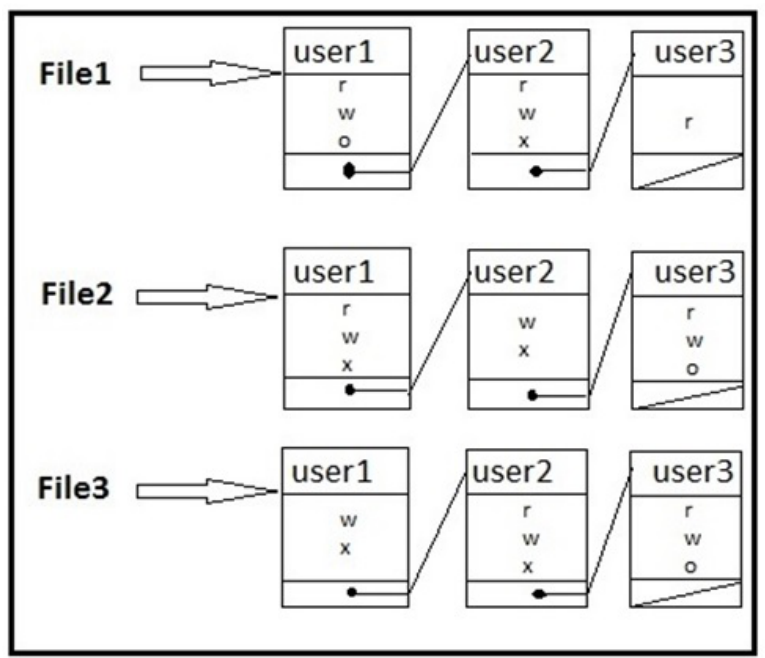
Figure 3. Access Control